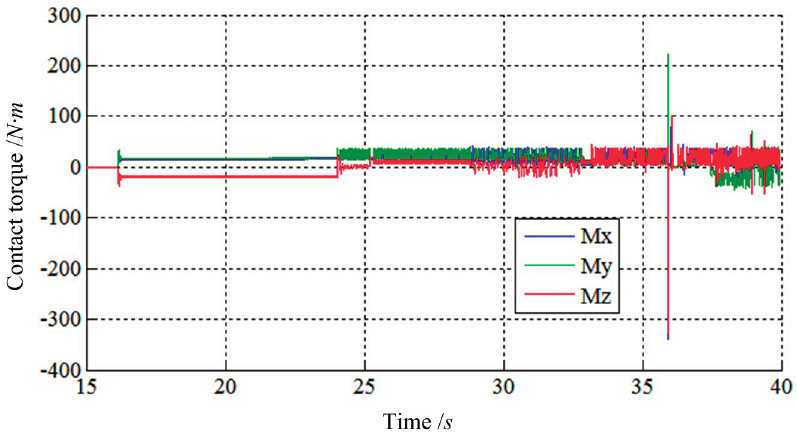
Figure 21. The torque tracking results based on Equation (13).